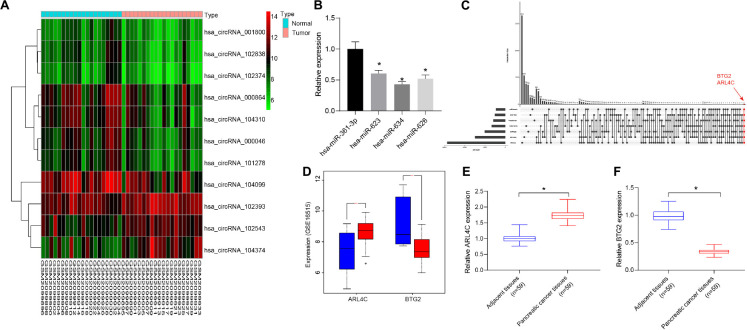
CircRNA_000864 may affect pancreatic cancer development by mediating B-cell translocation gene 2 (BTG2) through miR-361-3p. (A) Heatmap of 10 differentially expressed circular RNAs (circRNAs) in pancreatic cancer circRNA gene expression dataset GSE79634. The abscissa indicates the sample number, the ordinate indicates the differentially expressed gene, and the right upper histogram is the color gradation. Each rectangle in the figure corresponds to one sample expression value. (B) Expression of miRNAs in pancreatic cancer tissues (n = 59). (C) The comparison between the target gene predicting results of miR-361-3p in TargetScan, RNA22, miRWalk, miRSearch, starBase, and HOCTAR, and the results of differential analysis of GSE16515. The red dot-line indicates that there are two overlapped genes. (D) ARL4C and BTG2 expression in the GSE16515 gene expression datasets. Red indicates tumor tissue, and blue indicates normal tissue. (E) ARL4C BTG2 expression in pancreatic cancer tissues. (F) BTG2 expression in pancreatic cancer tissues. *p < 0.05 vs. adjacent normal tissues. The above data were all measurement data and expressed as mean ± standard deviation. The paired t-test was employed to compare data between two groups. One-way analysis of variance (ANOVA) was adopted for comparison among multiple groups.